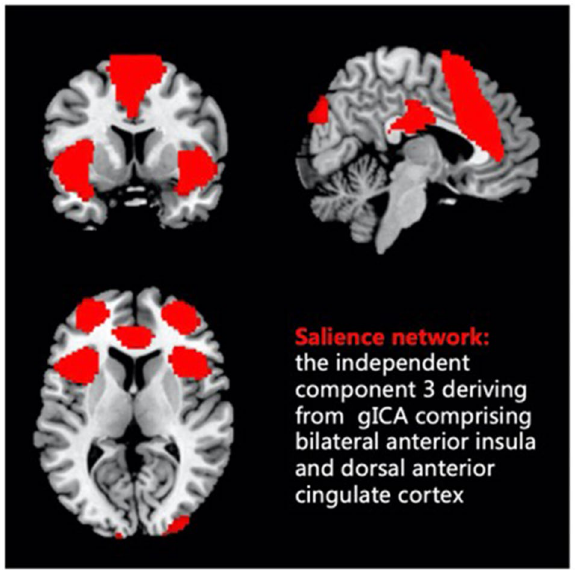
Figure 1. The salience network component identified from group independent component analysis (gICA) of the resting-state fMRI data of all subjects (n =